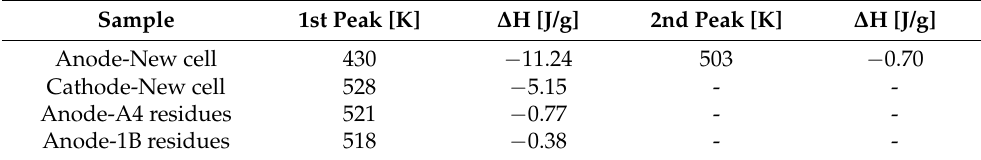
Table 2. DSC results.